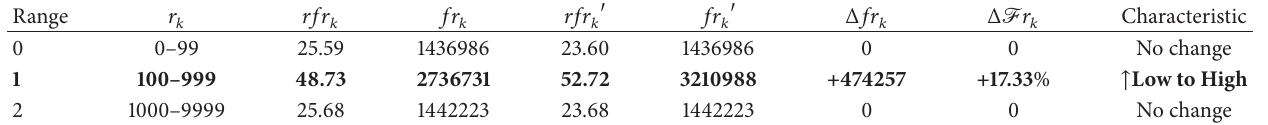
Table 14: Characterization of malicious insertion attacks on range of data values.